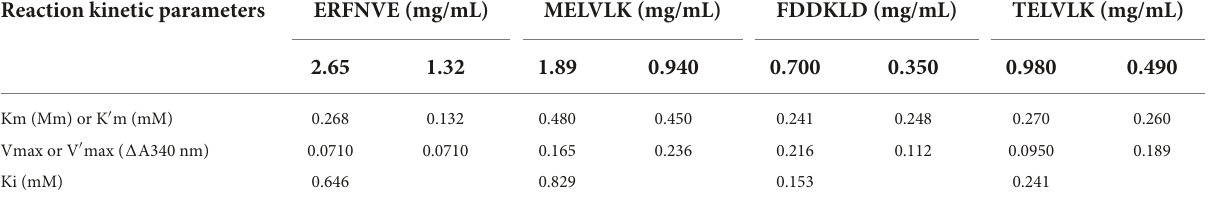
TABLE 7 Kinetics parameters of ACE-catalyzed reactions in four